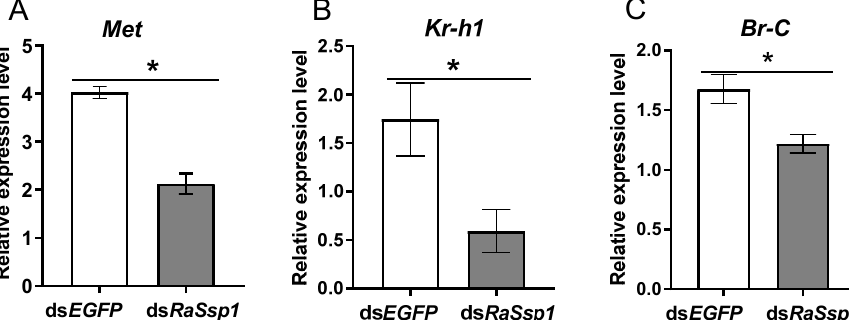
Figure 6. The expression levels of JH signal related gene in the head of presoldiers on the 3rd day after injection of RaSsp1 dsRNA. RaSsp1 dsRNA was injected at the beginning of the gut-purging period in presoldiers, with EGFP dsRNA as control. ( A ) Met , ( B ) Kr-h1 , ( C ) Br-C . Asterisks indicate a significant difference (one-way ANOVA followed by LSD test using SPSS, * p < 0.05).